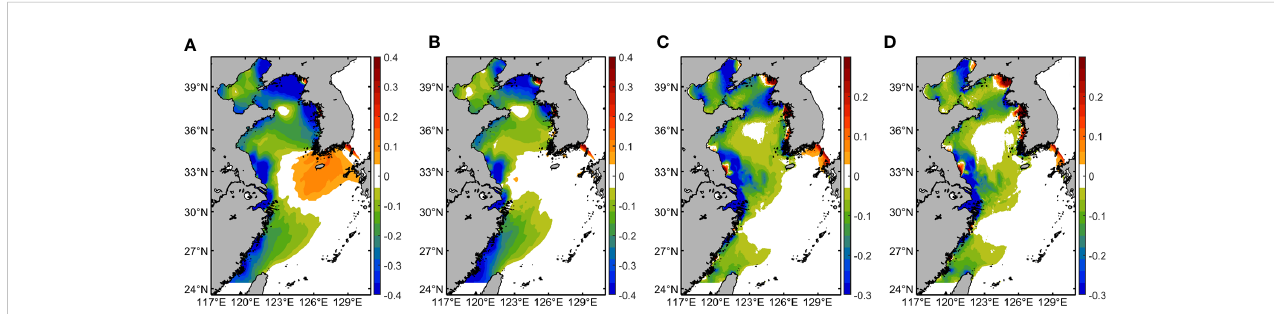
FIGURE 6 (A, B) Differences between the maximum tidal elevations (MTE) of EXP 1 and EXP 2 to those of EXP 3 (MTE EXP1,2 - MTE EXP3 , unit: m). (C, D) Differences between the maximum bottom current velocity (MCV) of EXP 1 and EXP 2 to those of EXP 3 (MCV EXP1,2 - MCV EXP3 , unit: